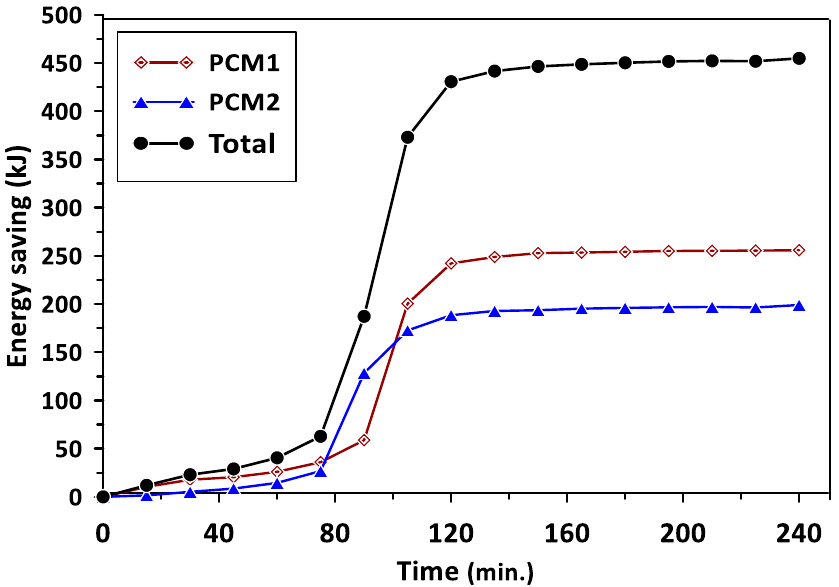
Figure 10. Energy saving of PCM1 and PCM2 during the charging cycle.